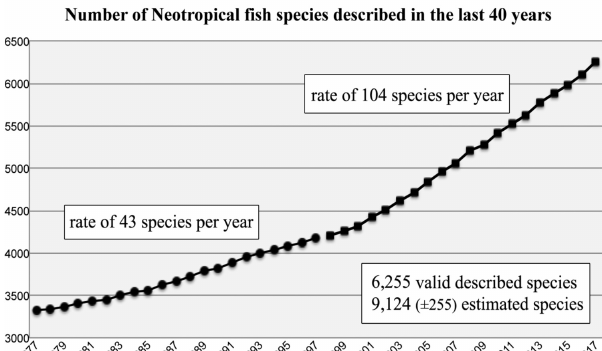
Fig. 1. Accumulative curve of valid freshwater species described by year from 1977 to 2017 (last 40 years) in the Neotropical region (based on Reis et al ., 2003, and Fricke et al ., 2018), showing an increased rate of species description in the beginning of the twenty-first century, and the estimate number of total valid species for the region based on Jackknife